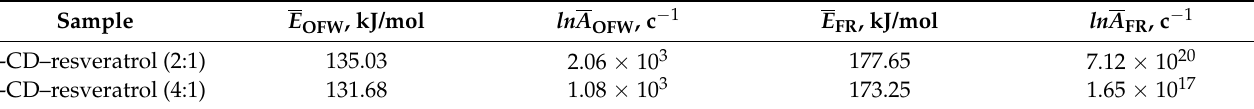
Table 2. Kinetic parameters of the thermal degradation of β -CD–resveratrol clathrates (2:1, 4:1).